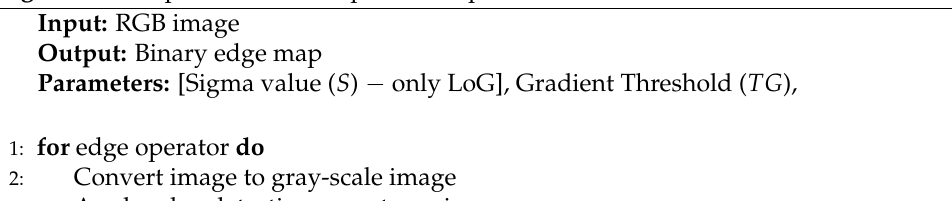
Algorithm 3 Laplace and LoG Operator